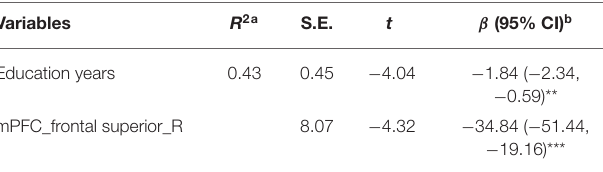
TABLE 4 | Multivariate linear regression analysis to predict relapse severity ( n = 35). Variables R 2a S.E. β (95% CI)